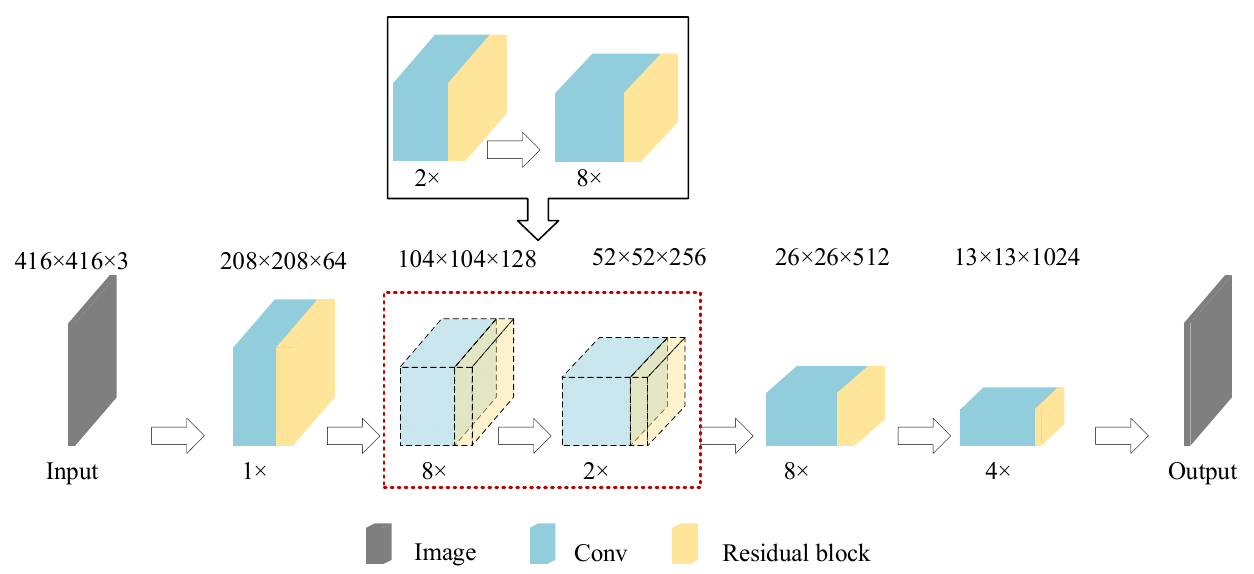
Figure 8. Residual block. (The black box is the original residual block, and the red box is the modified residual block).